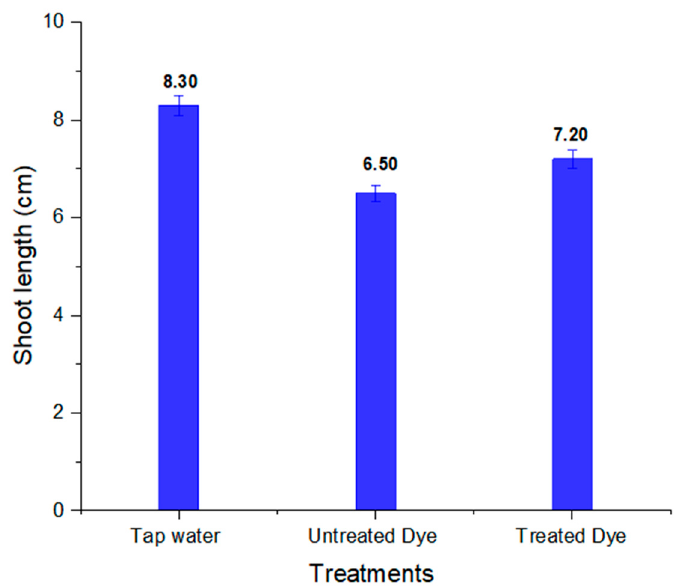
Figure 15. Shoot length of Vigna radiata in tap water and in untreated and treated orange II dye.